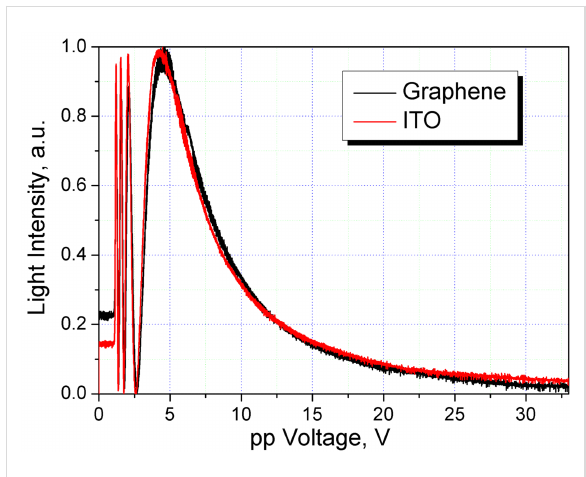
Figure 5: Light intensity vs peak-to-peak (pp) voltage applied, passing through the liquid crystal cell with ITO and graphene layers.